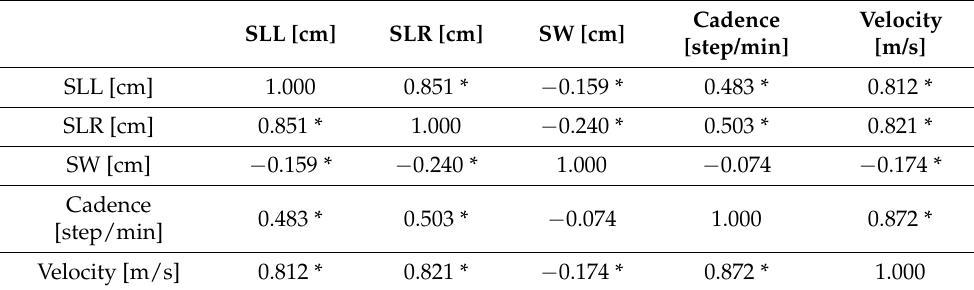
Table 1. Spearman rank order correlation. SLL [cm]—step length left, SLR [cm]—step length right, SW [cm]—step width * The marked correlation coefficients are significant at p < 0.05000.